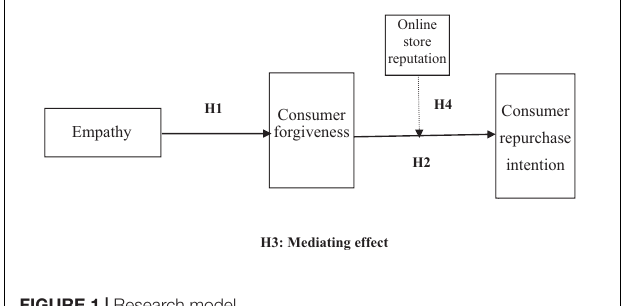
FIGURE 1 | Research